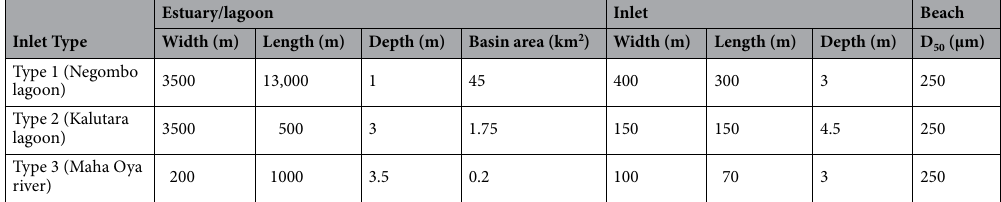
Table 2. Key dimensions for the 3 systems required as model